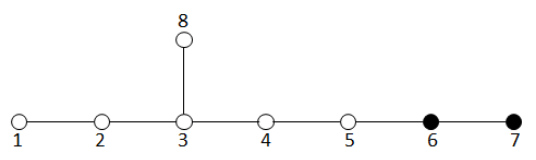
Figure 1 . The Dynkin diagram of E 8 . The Dynkin node labelled i corresponds to the exceptional divisor D . The solid nodes are the ones we break by vertical flux, while we preserve a linear com- i bination of their corresponding Cartan generators. The unbroken nodes form the Dynkin diagram of E 6